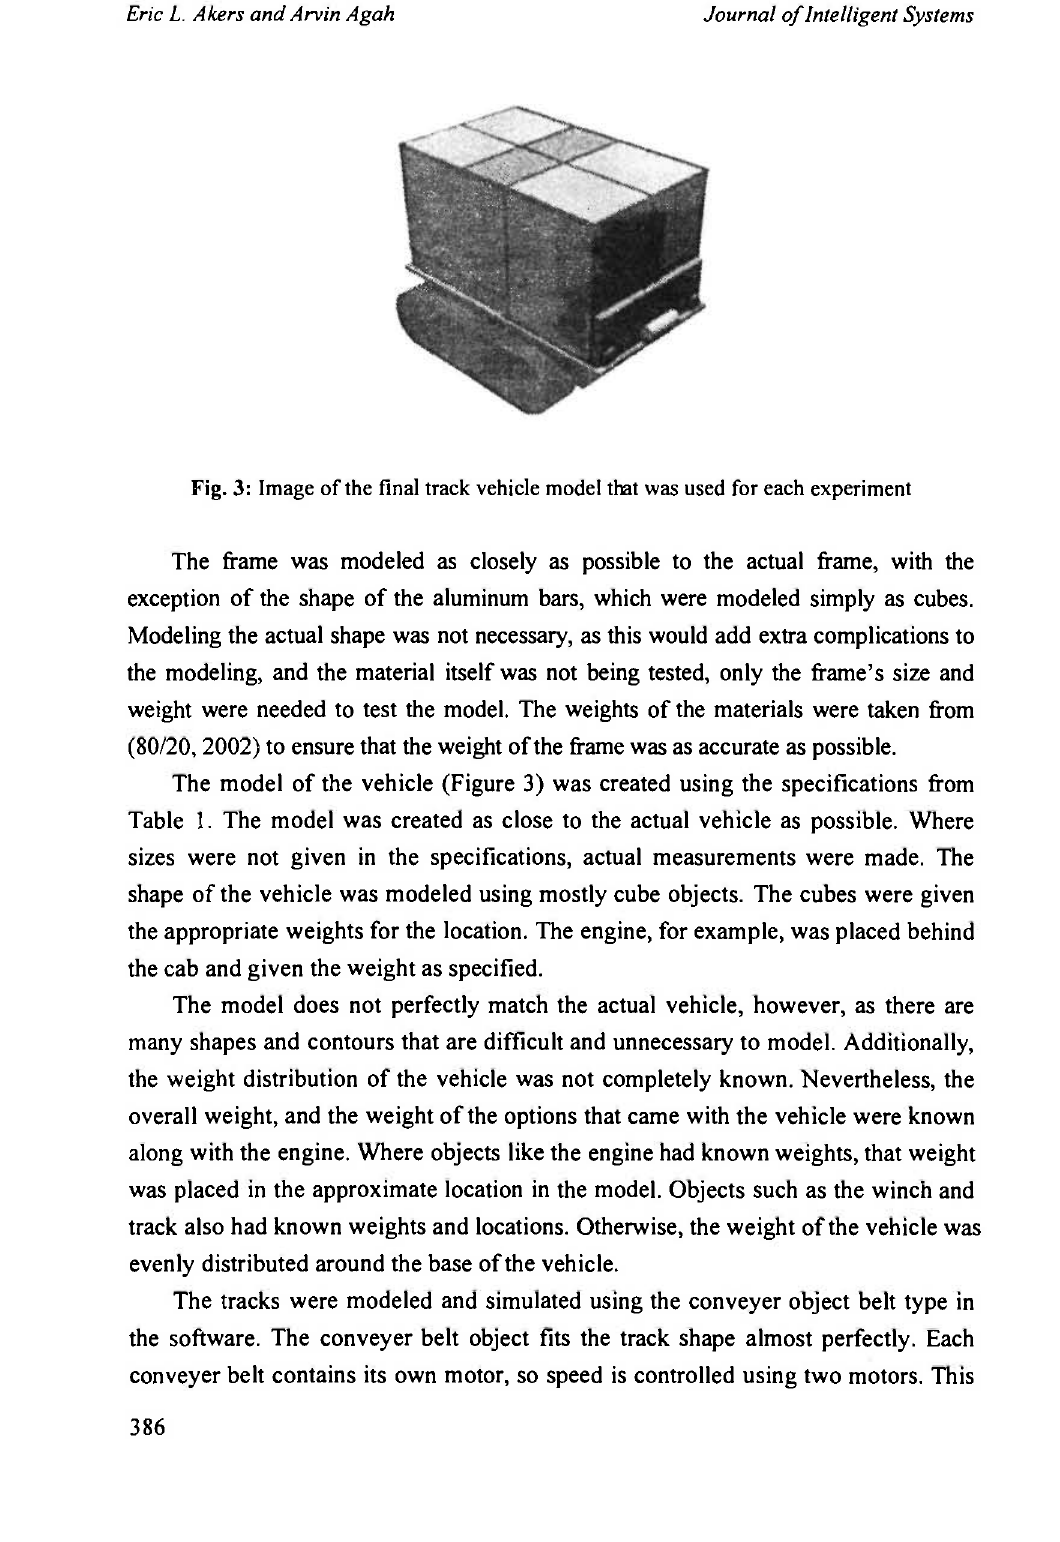
Fig. 3: Image of the final track vehicle model that was used for each experiment